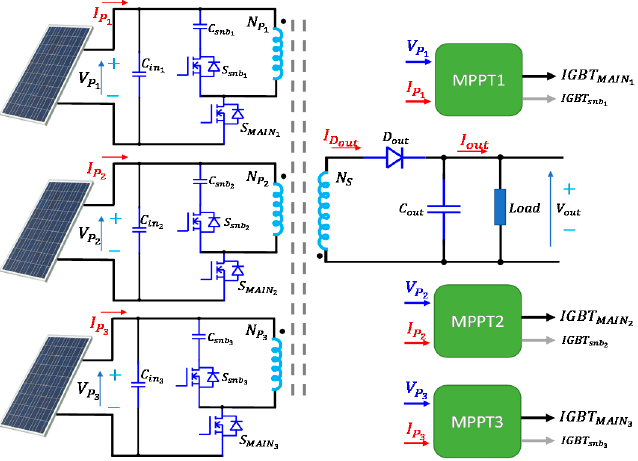
Figure 10. Schematic of the MPPT for the topology proposed.